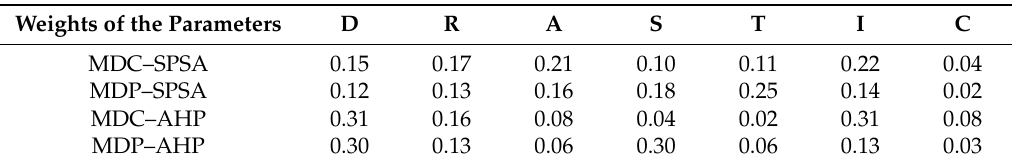
Table 7. The weights of the parameters obtained by SPSA and AHP. SPSA: Single-Parameter Sensitivity Analysis, AHP: Analytic Hierarchy